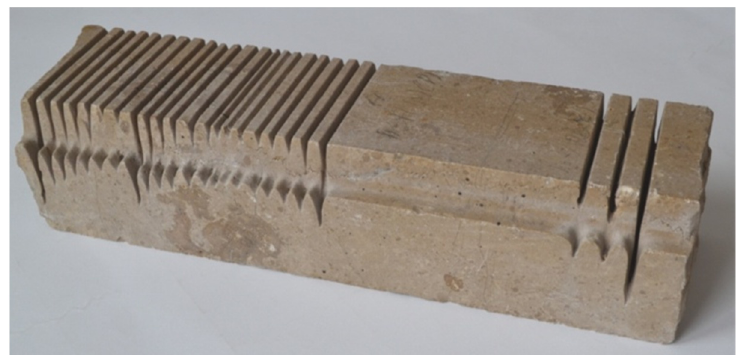
Figure 2. Limestone from Morawica quarry.